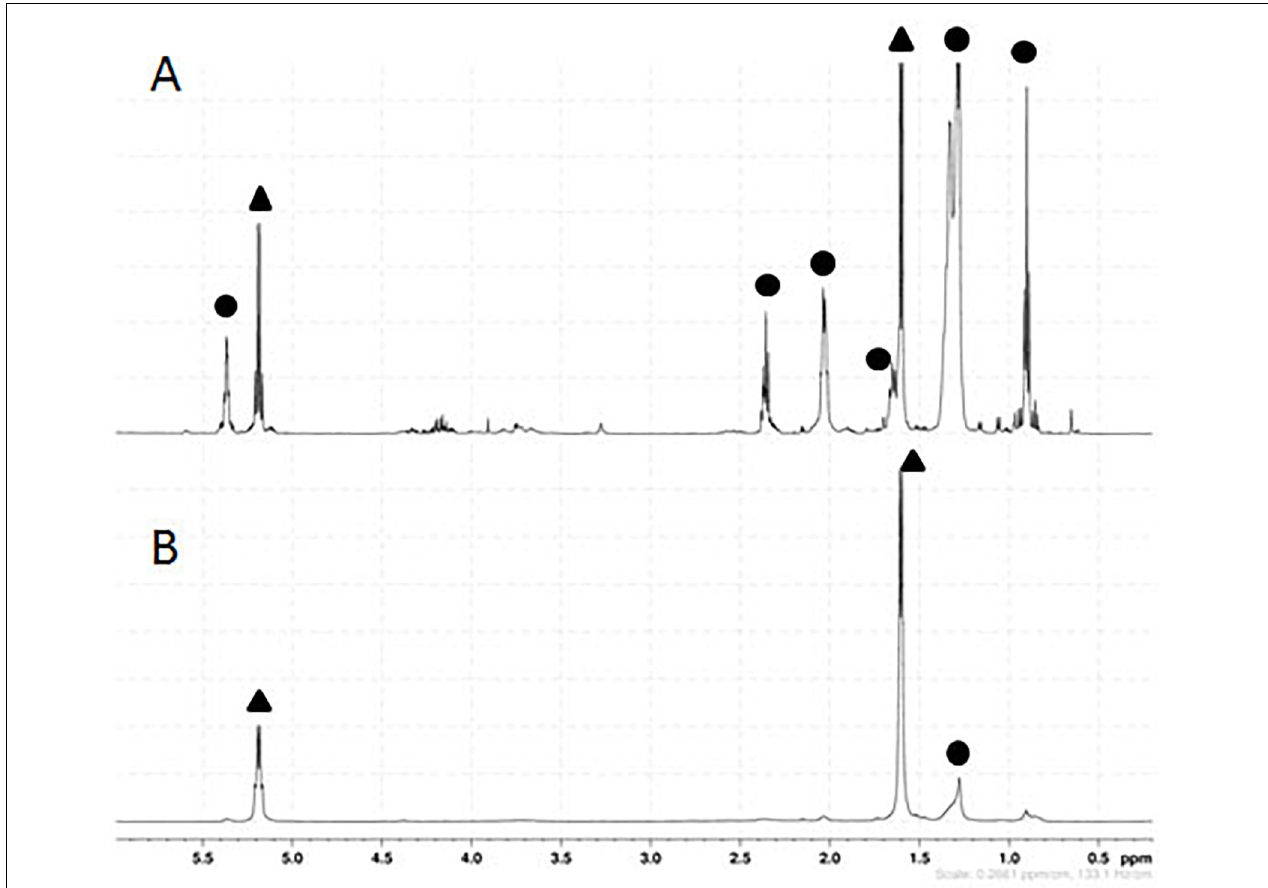
FIGURE 5 | Proton nuclear magnetic resonance (1H-NMR) spectra of PLA. PLA was extracted from lyophilized culture of CS TEF-CpPCTc + TEF-PaPHAp strain using chloroform soxhlet (A) and then purified (B) . Signals pertaining to PLA are designated by a black triangle, whilst signals belonging to free fatty acids from the cellular extraction are indicated by a black circle. These experiments are representative of three independent